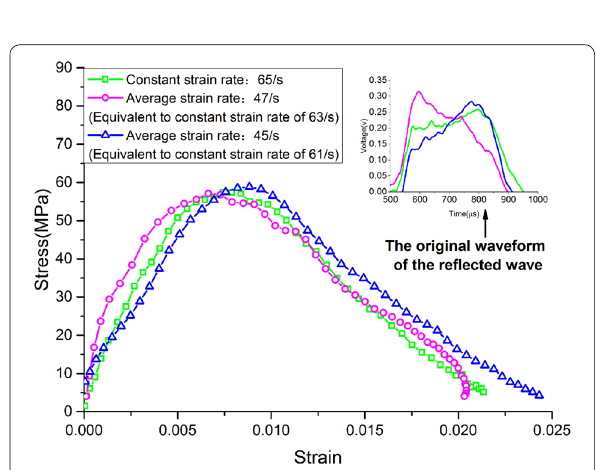
Fig. 6 Experimental data under different loading